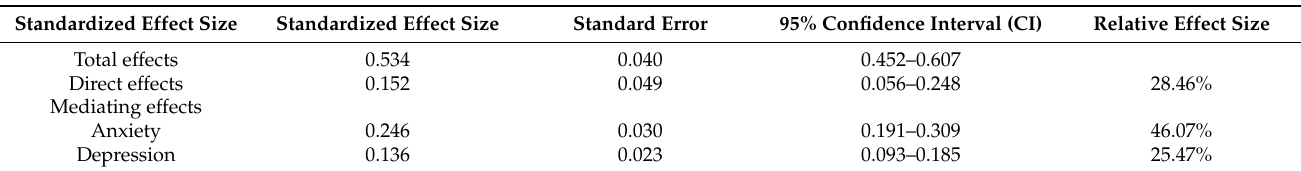
Table 4. The estimates of total, direct, and indirect effects of the model (with anxiety and depression as mediating